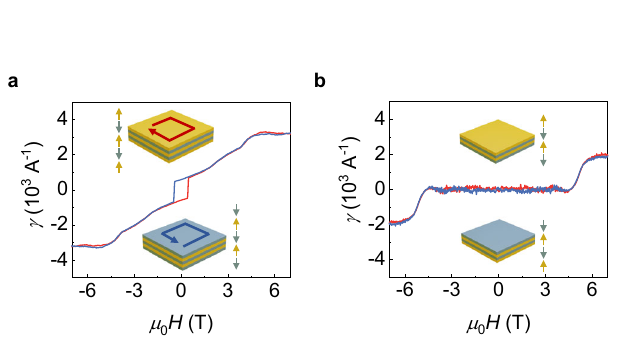
Fig. 3 | Non-reciprocal charge transport in 5-SL MnBi 2 Te 4 and 4-SL MnBi 2 Te 4 . a Magnetic fi eld dependent non-reciprocity for a 5-SL MnBi 2 Te 4 device. A top gate voltage of 3V isapplied,and the sampleisslightly electron doped.Insets show the schematic illustrations of two magnetic states under zero magnetic fi eld. b Magnetic fi eld dependent non-reciprocity for a 4-SL MnBi 2 Te 4 device. The AC driven current I RMS =1 μ A is adopted in measurements. The measurements are performed at the temperature of 11K. A top gate voltage of 3V is applied, and the sample is slightly electron doped. Insets show schematic illustrations of two mag- netic states under zero magnetic fi